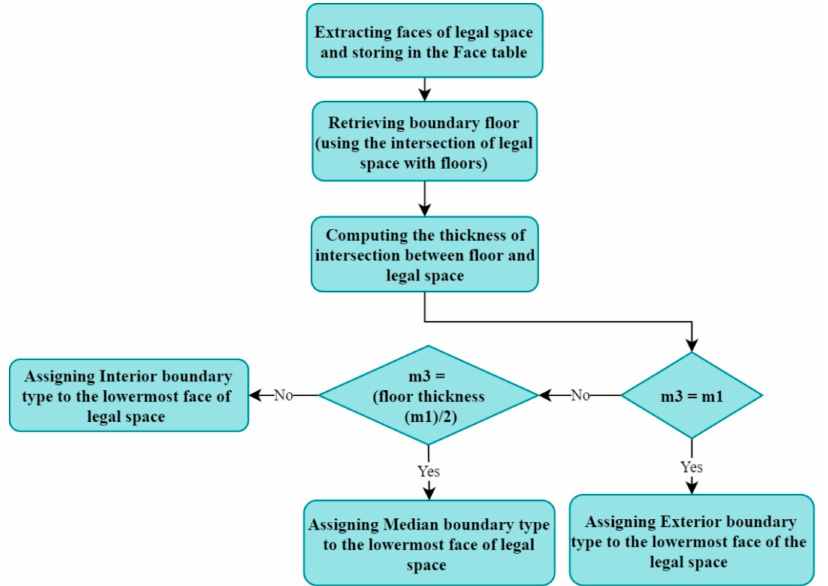
Figure 3. A methodology for detecting different types of property boundaries associated with floor.